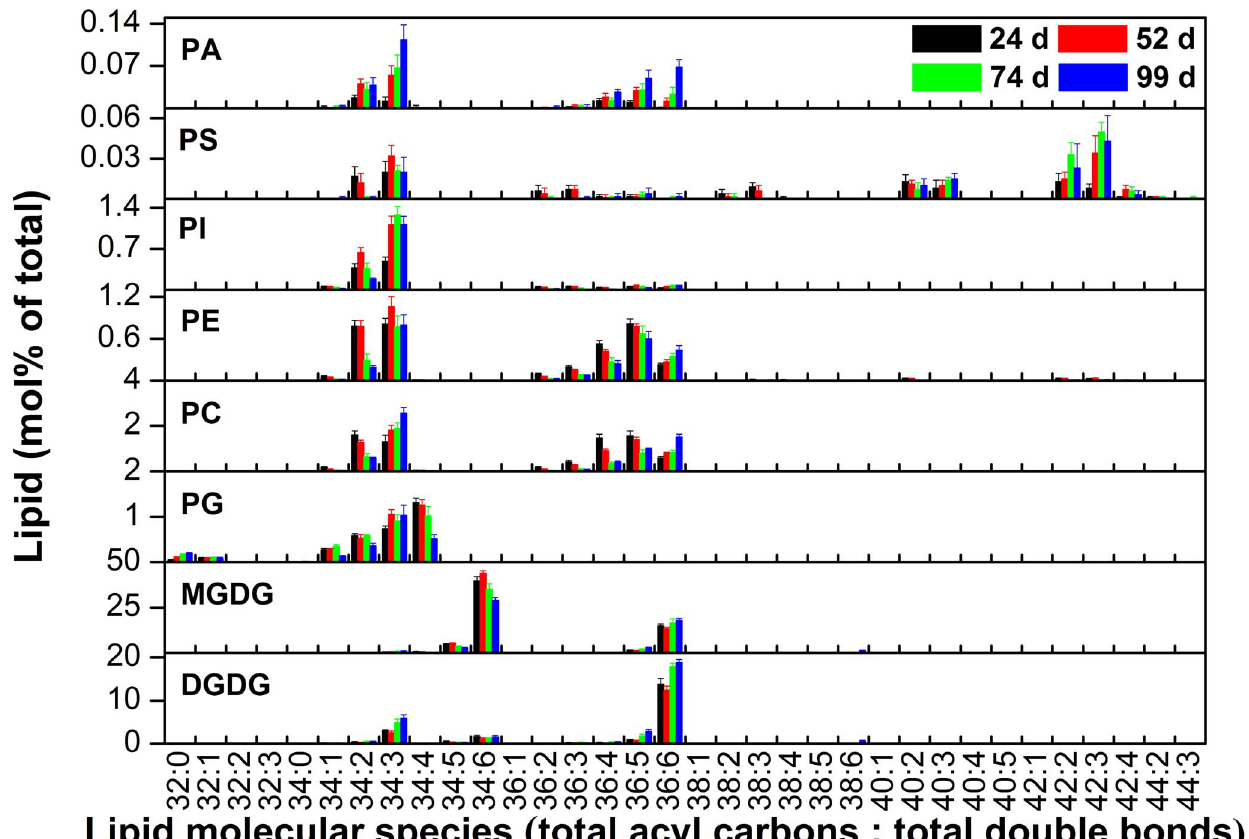
Figure 2. The relative composition (mol%) of lipid molecular species during development of leaves after germination. Values are means 6 s.d. ( n =5).